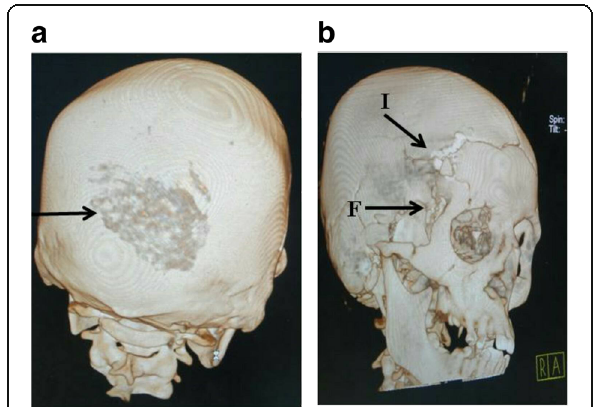
Fig. 1 Gunshot injuries of the head. a PMCT-3D-volume rendering image showing a comminuted fracture (F) opposite the exit in the occipital bone. b MDCT-3D-volume rendering image showing the entry wound of firearm injury (I) in the right temple and multiple fractures (F) of the skull bone in the right sphenoid wing, right temporal, right frontal, and right occipital bone